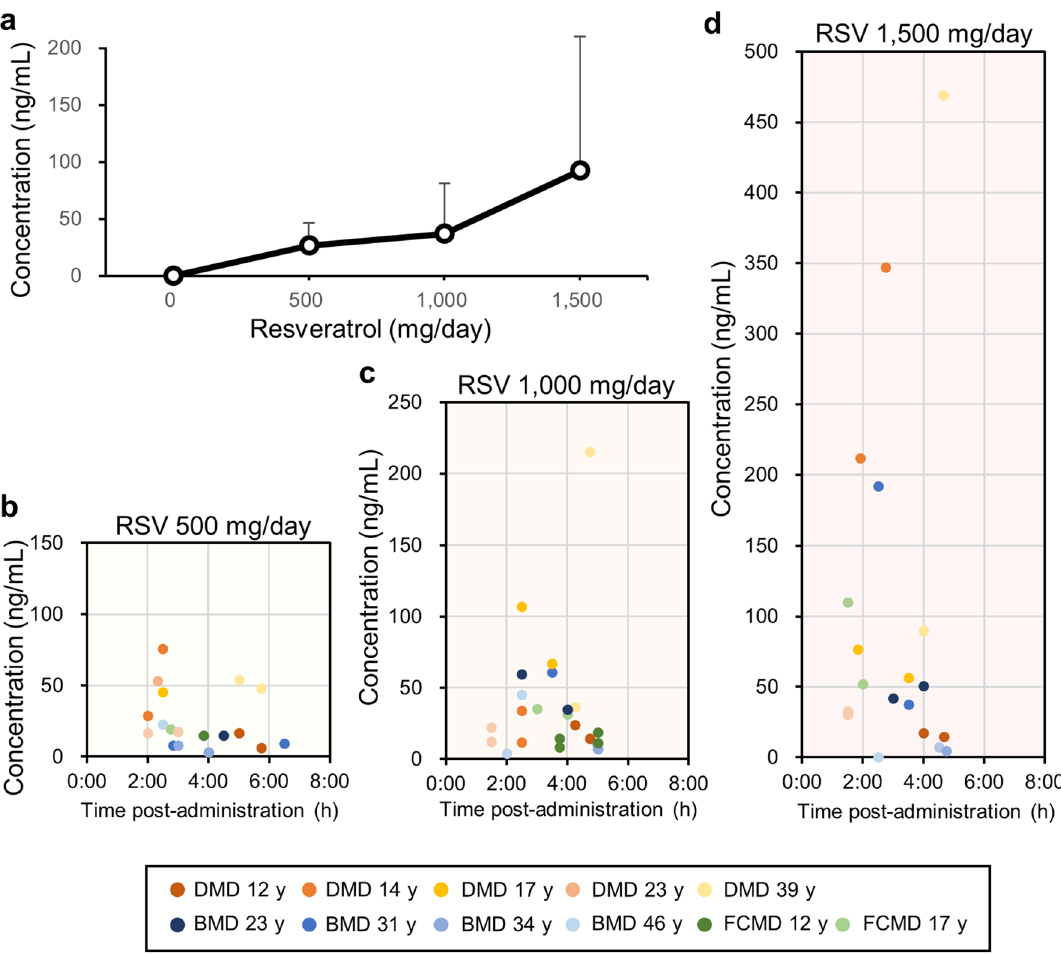
Figure 5. Serum resveratrol concentration at doses of 500, 1000, and 1500 mg/day. ( a ) Mean serum resveratrol levels of all participants with standard deviation (N = 11). ( b – d ) Serum resveratrol level and time from resveratrol ingestion to blood drawing in each patient are shown by a dot. RSV: resveratrol.